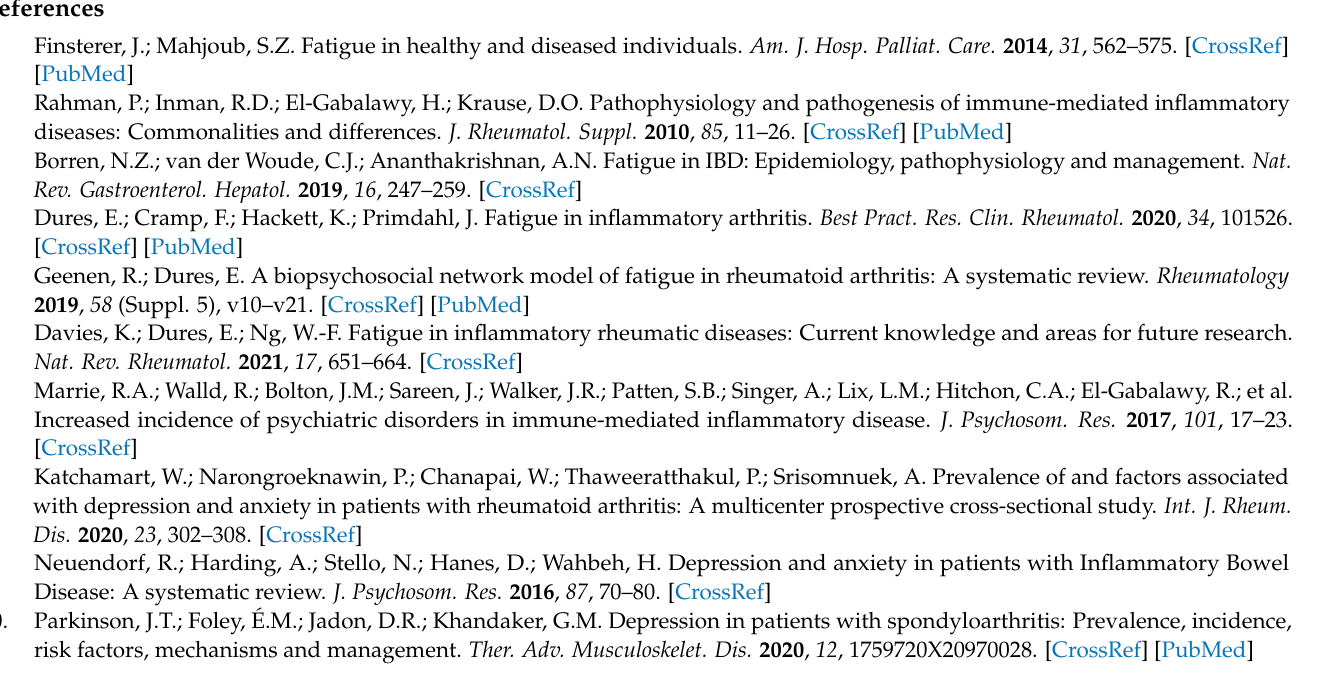
Table S3: Multivariable logistic regression model for Fatigue in IBD patients; Table S4: Multivariable logistic regression model for Fatigue in IA